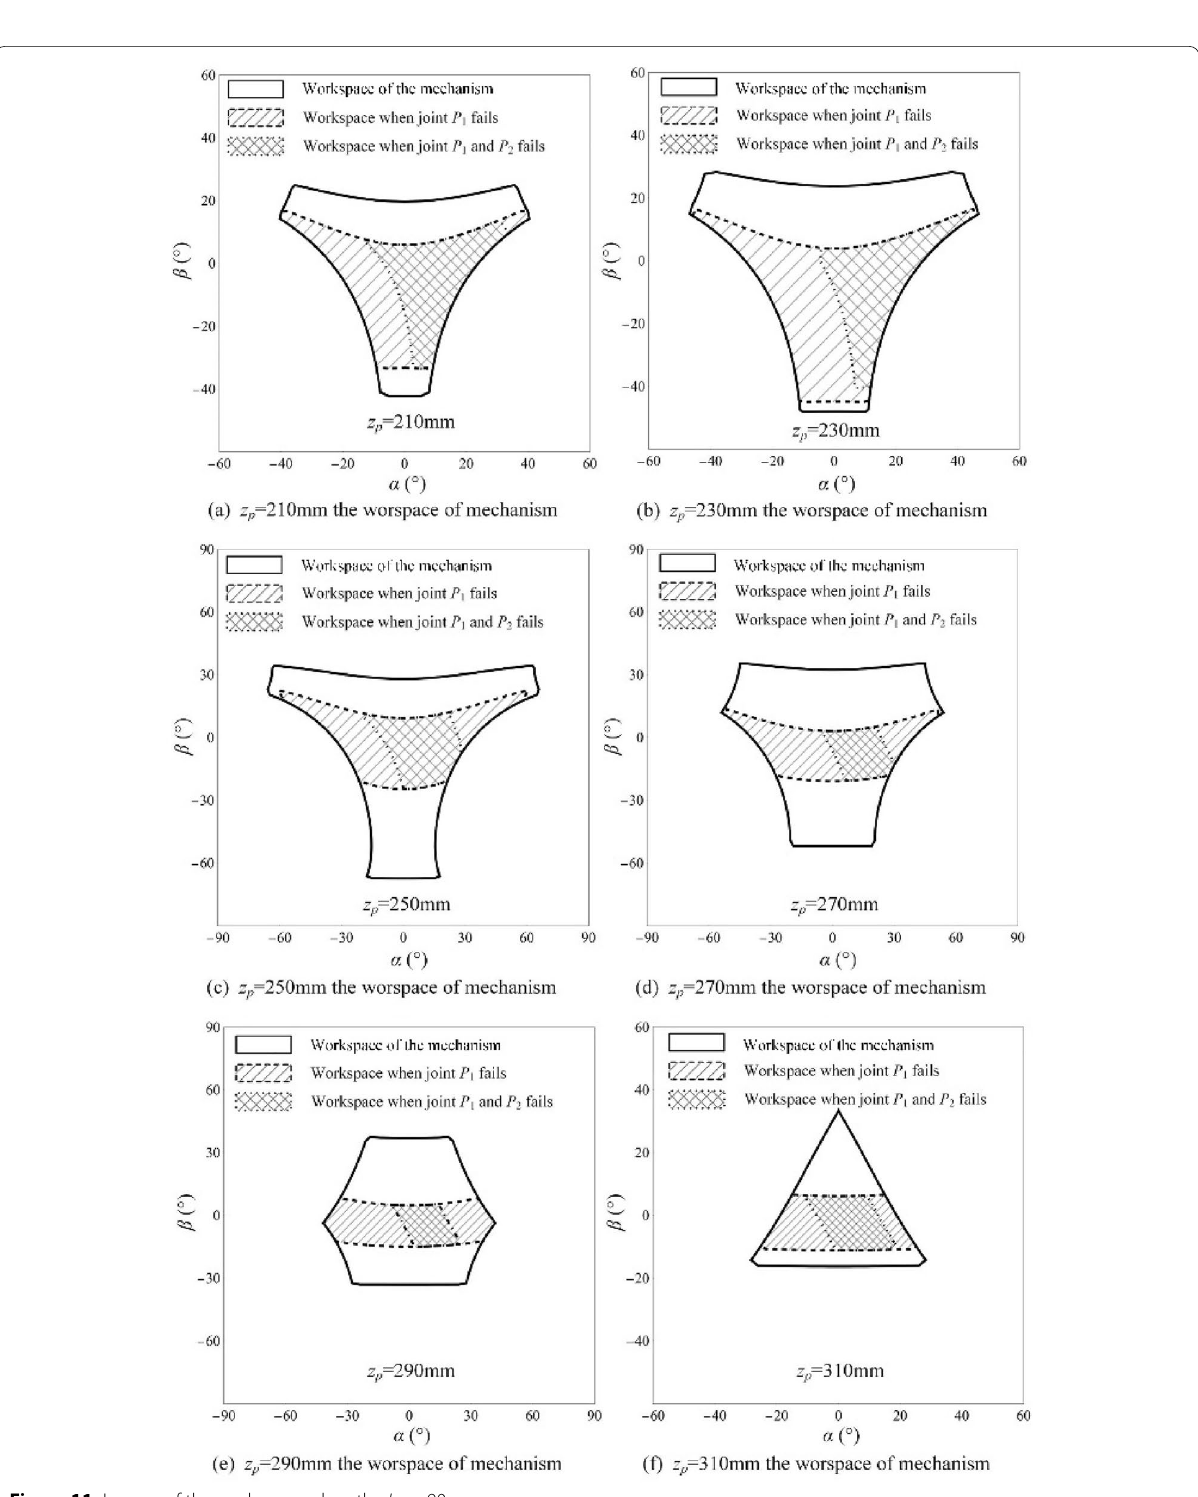
Figure 11 Images of the workspace when the L 4